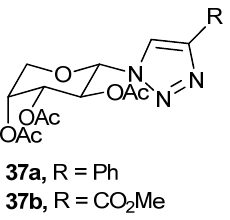
Figure 26. Per ‐ O ‐ acetyl ‐β‐ D ‐ arabinopyranosyl triazoles.